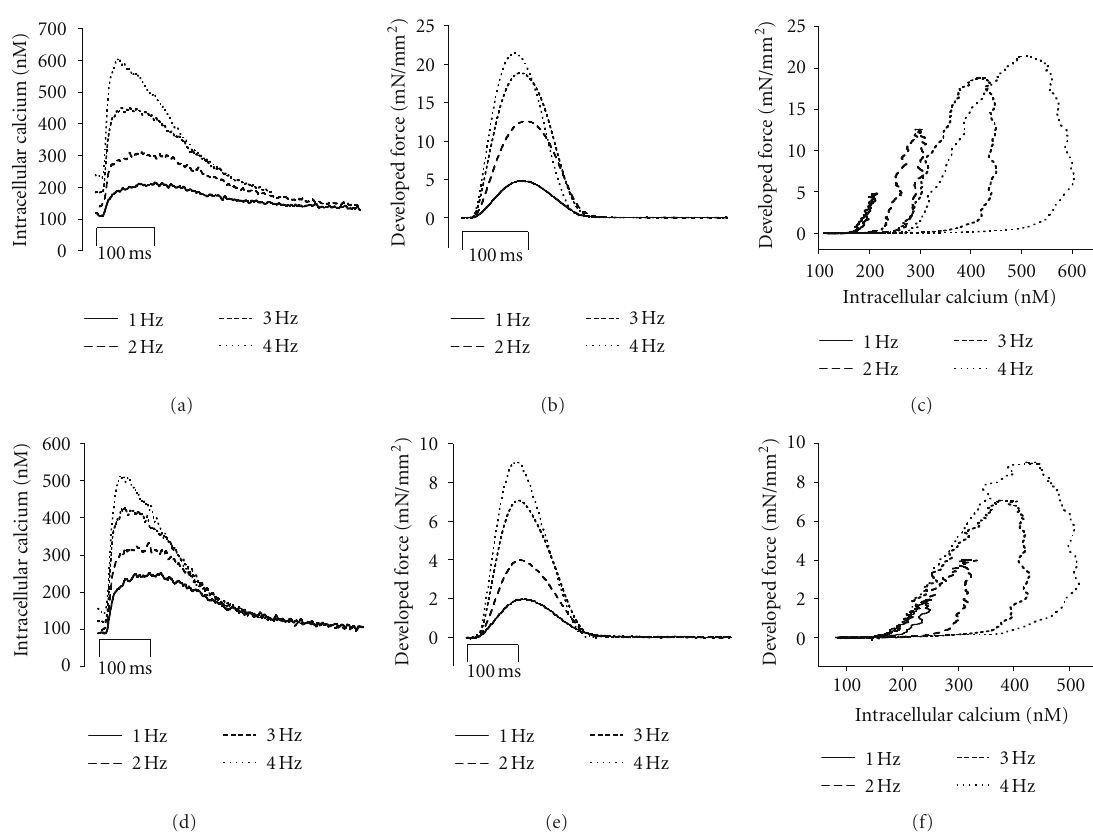
Figure 1: Panels (a), (b), and (c) show representative calcium transients (a), force tracings (b), and corresponding phase plane plots (c) from rabbit right ventricular trabeculae stimulated to contract at 1, 2, 3, and 4Hz (37 ◦ C). Note the shift to the right of the relaxation trajectory of the phase plane plots. The same preparation was then treated with 100 nM staurosporine and the protocol repeated. Calcium transients (d), force tracings (e), and the resulting phase planes (f) are shown. Note the elimination of the relaxation trajectory shift after the addition of